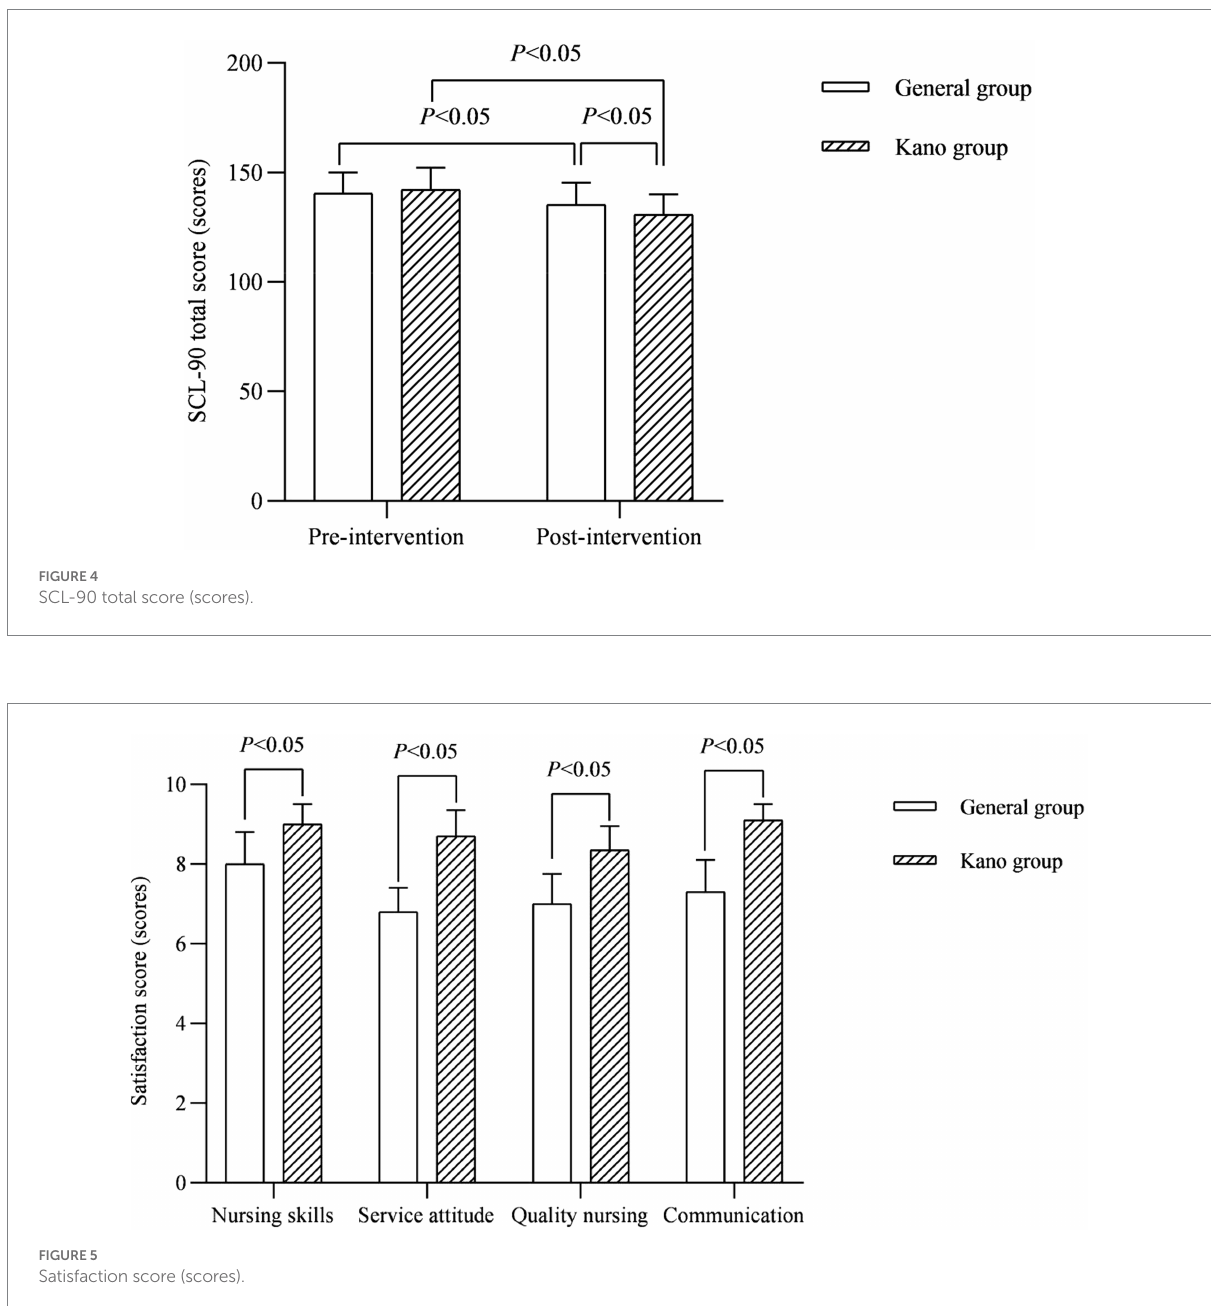
FIGURE 5 Satisfaction score